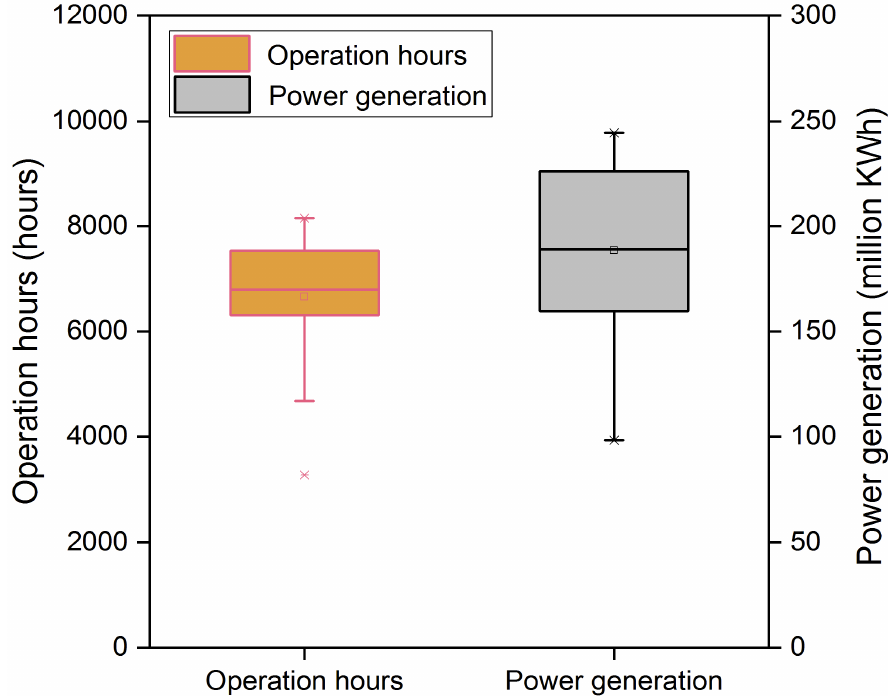
Figure 7. The annual operation hours and power generation of biomass based power plant in AHP, 2016.